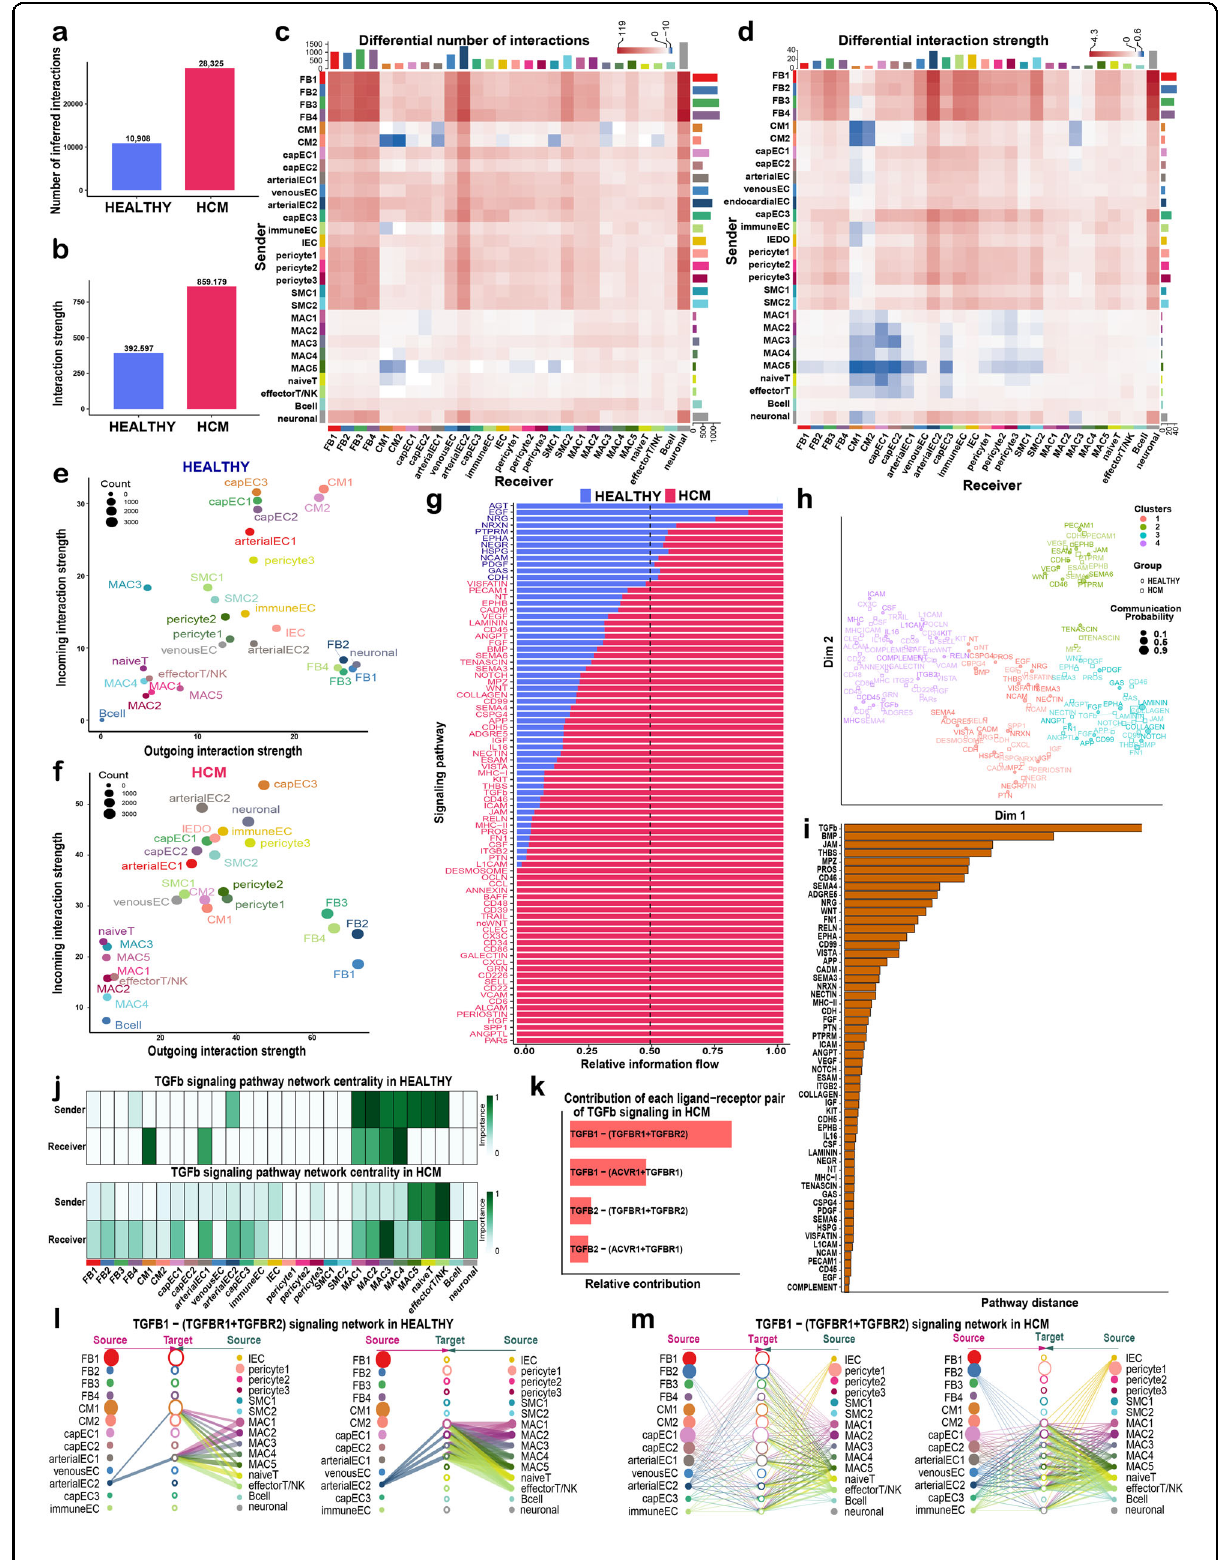
Fig. 5 (See legend on next